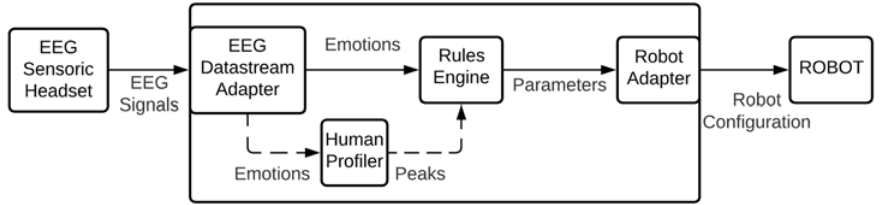
Figure 2. System architecture for human emotion ‐ driven robot configurator.